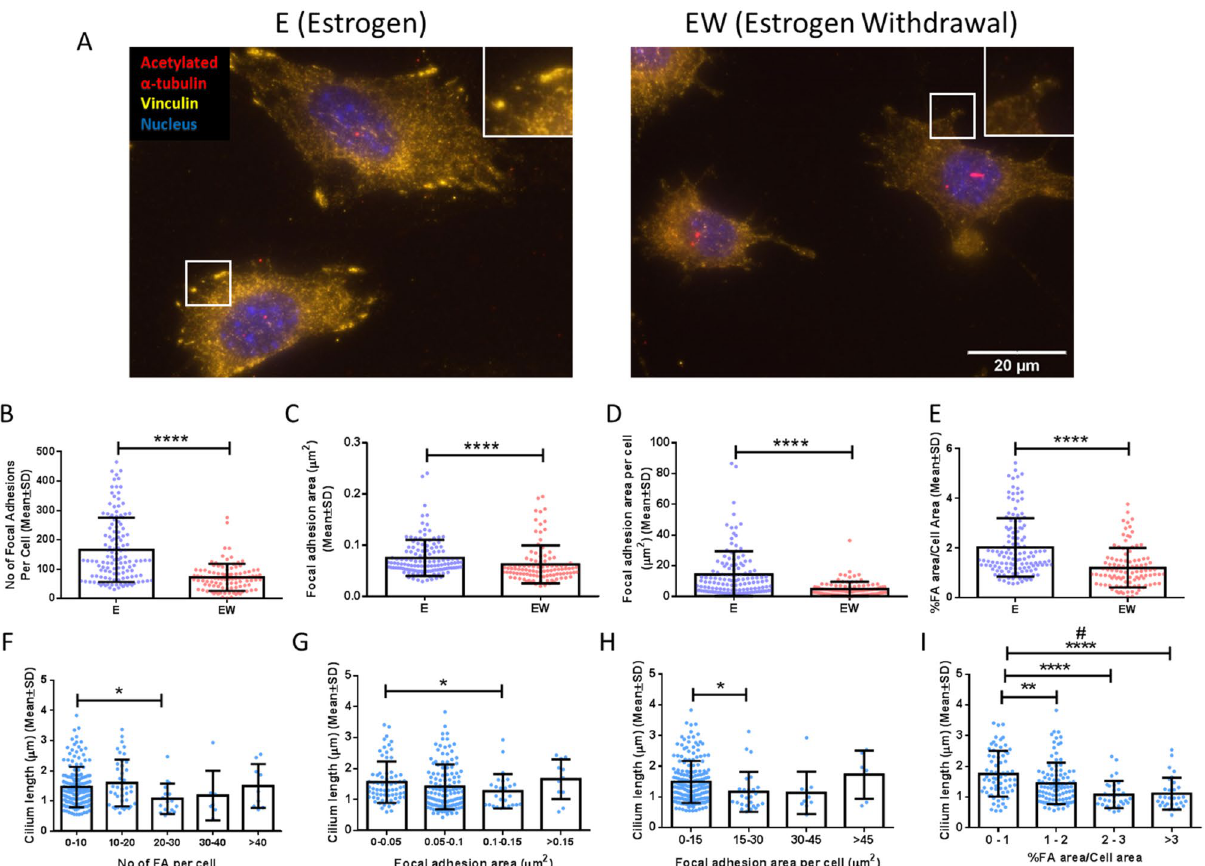
Figure 4. The effect of estrogen withdrawal on the role of the focal adhesion assembly in primary cilium dynamics. (A) Immunocytochemistry images showing acetylated α-tubulin, vinculin, and nuclei staining (N = 3, n ≥ 104 cells per group). Quantification of the images showing (B) number of focal adhesions per cell, (C) focal adhesion area, (D) focal adhesion area per cell, and (E) % focal adhesion area/cell area. Quantification of the images to determine trend between primary cilium length and (F) number of focal adhesion area per cell, (G) focal adhesion area, (H) focal adhesion area per cell, and (I) % focal adhesion area/cell area. (Student’s t-test, *p < 0.05, **p < 0.01, ****p < 0.0001. One-way ANOVA to determine trend between groups, #p <